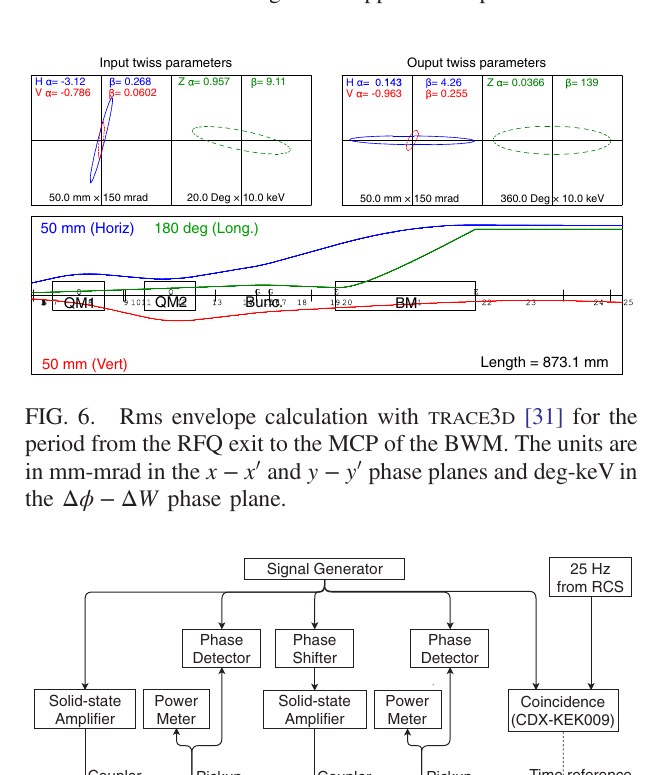
FIG. 7. Diagram of the 324 MHz rf system. Note that the broken-line arrows are not 324 MHz rf.